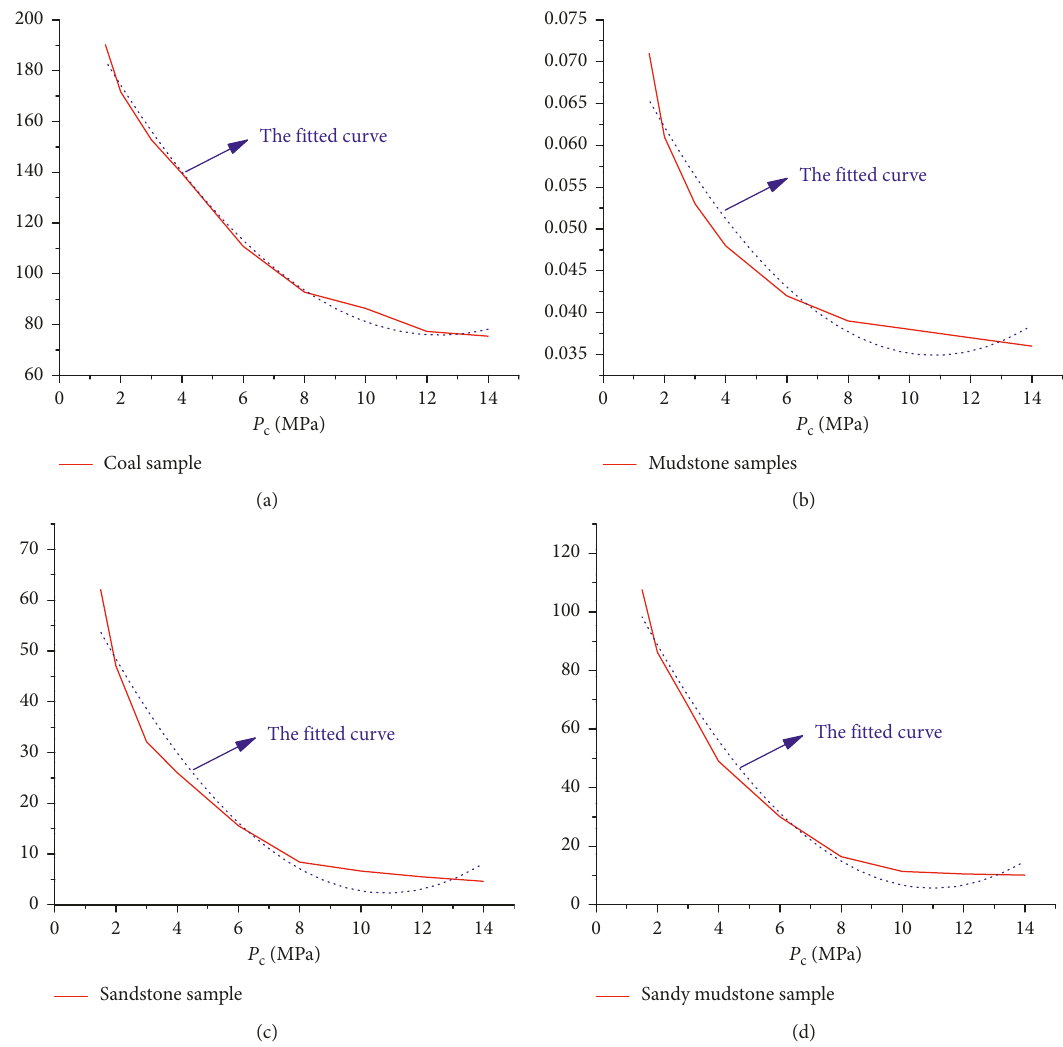
Figure 10 signifies maximum principal stress and